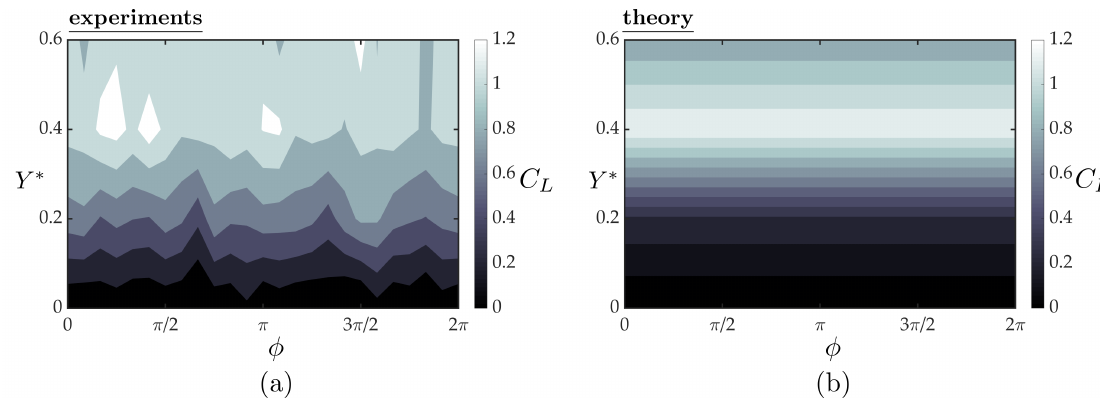
Figure 9. Lift of the follower hydrofoil as a function of the synchrony and cross-stream spacing from the experiments ( a ) and the three-dimensional quasi-steady theory ( b ). The follower is at a fixed streamwise spacing of X ∗ = 0.75 for all the cases presented